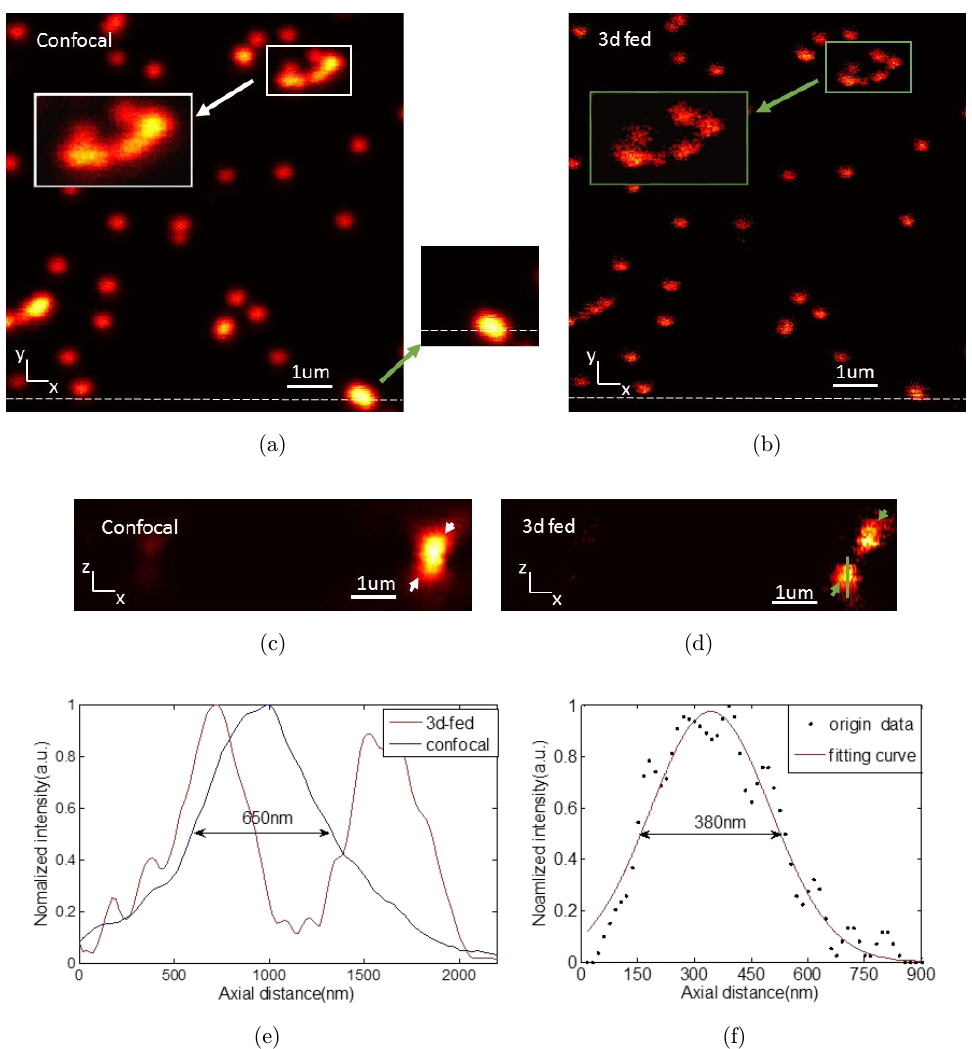
Fig. 6. Characterization of the lateral and axial resolution improvement using 0.1 (cid:6) m beads on a coverslip. (a), (b) x – y view of confocal and 3D-FED images by employing the 22/40 slices in stacks. (c) x – z view of the confocal image along the dashed line in (a), in the middle of (a) and (b) is the partly magni¯ed view of the dashed line. (d) Axial pro¯le of 3D-FED image counterpart to (c). (e) Line pro¯le intensity at the indicated direction in (c) and (d). (f) Intensity pro¯les along the z -axis extracted from (d) at the solid line, quantifying the axial resolution gain in 3D-FED method.